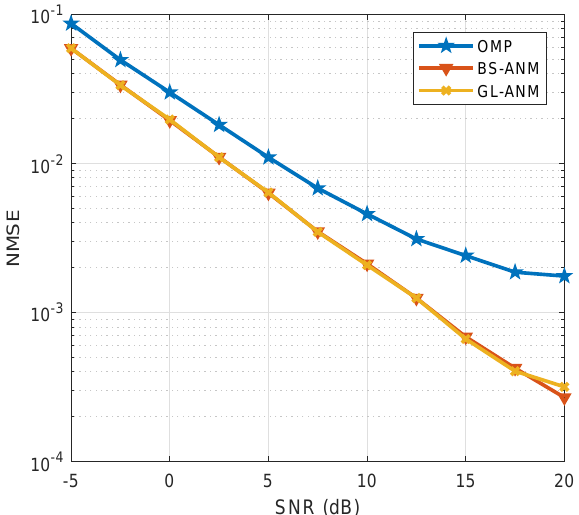
Figure 9. NMSE comparison of different channel estimation methods when SNR varies from − 5 to 20